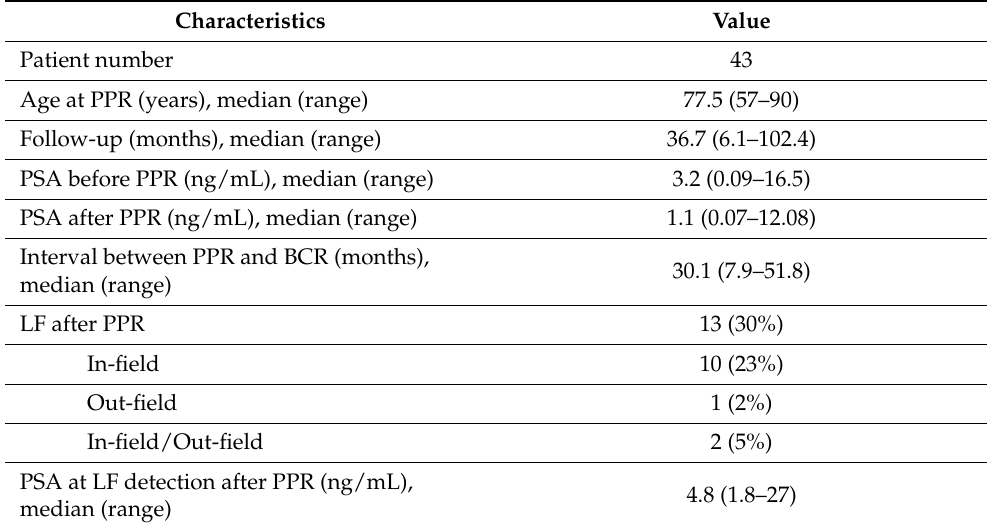
Table 1. Characteristics of patient cohort.